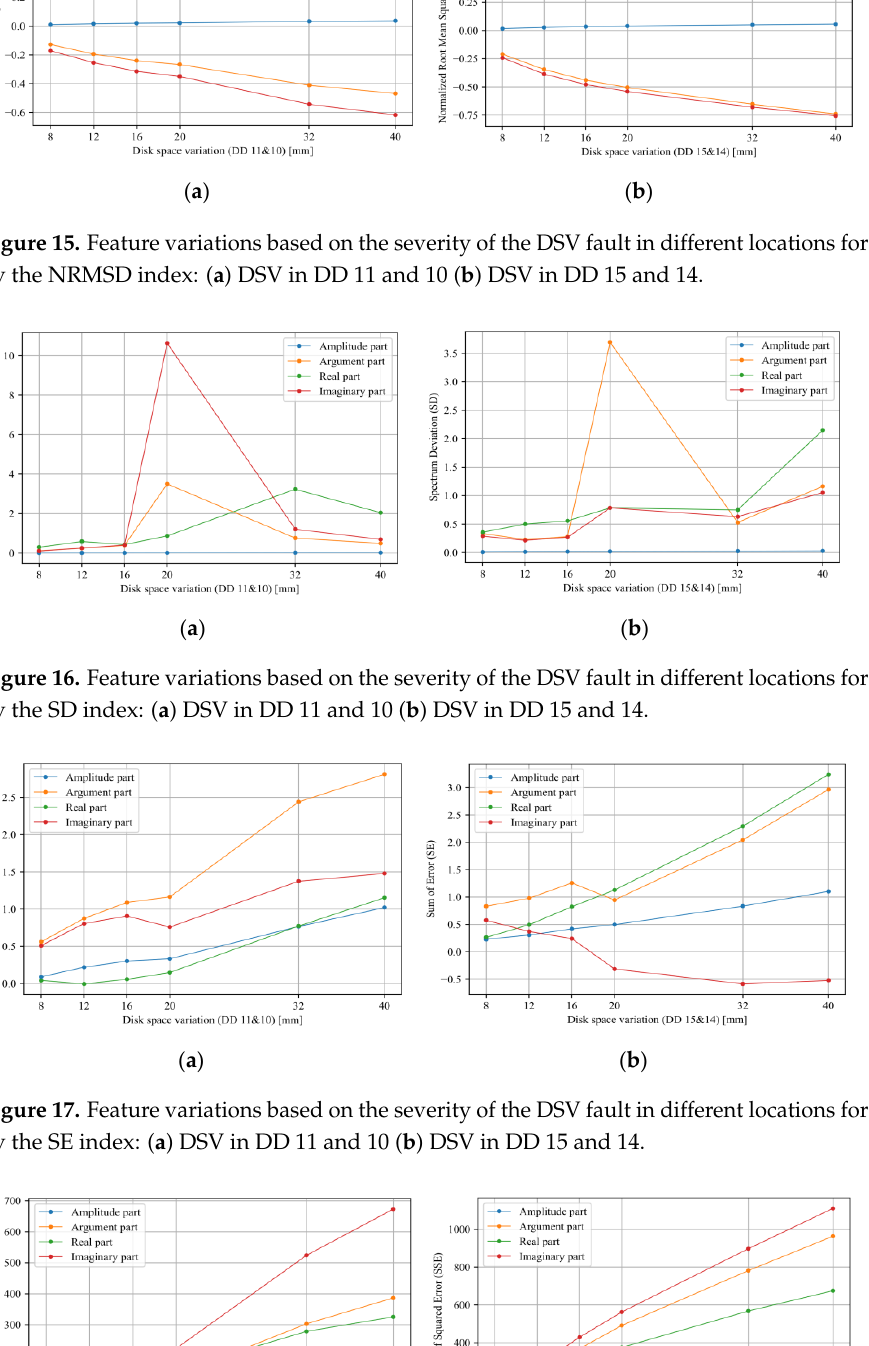
Figure 14. Feature variations based on the severity of the DSV fault in different locations for ex- tracted by the LCC index: ( a ) DSV in DD 11 and 10 ( b ) DSV in DD 15 and 14.